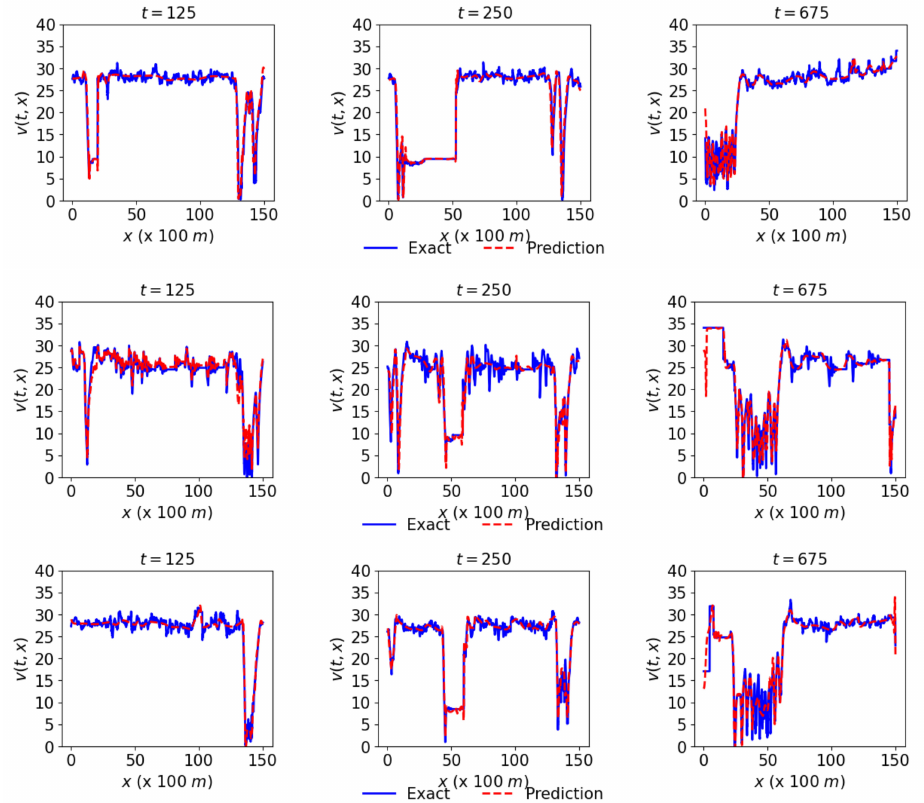
Figure 7. Actual and predicted speed at three different times 125, 250, and 675 respectively given by the first, second, and third columns. The first, second, and third rows respectively represent the network’s links L1, L2, and